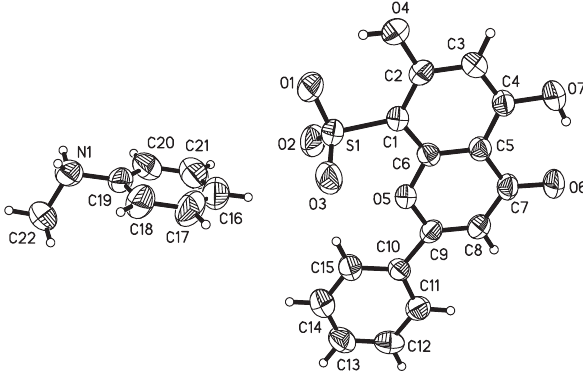
Table 1: Data collection and handling.